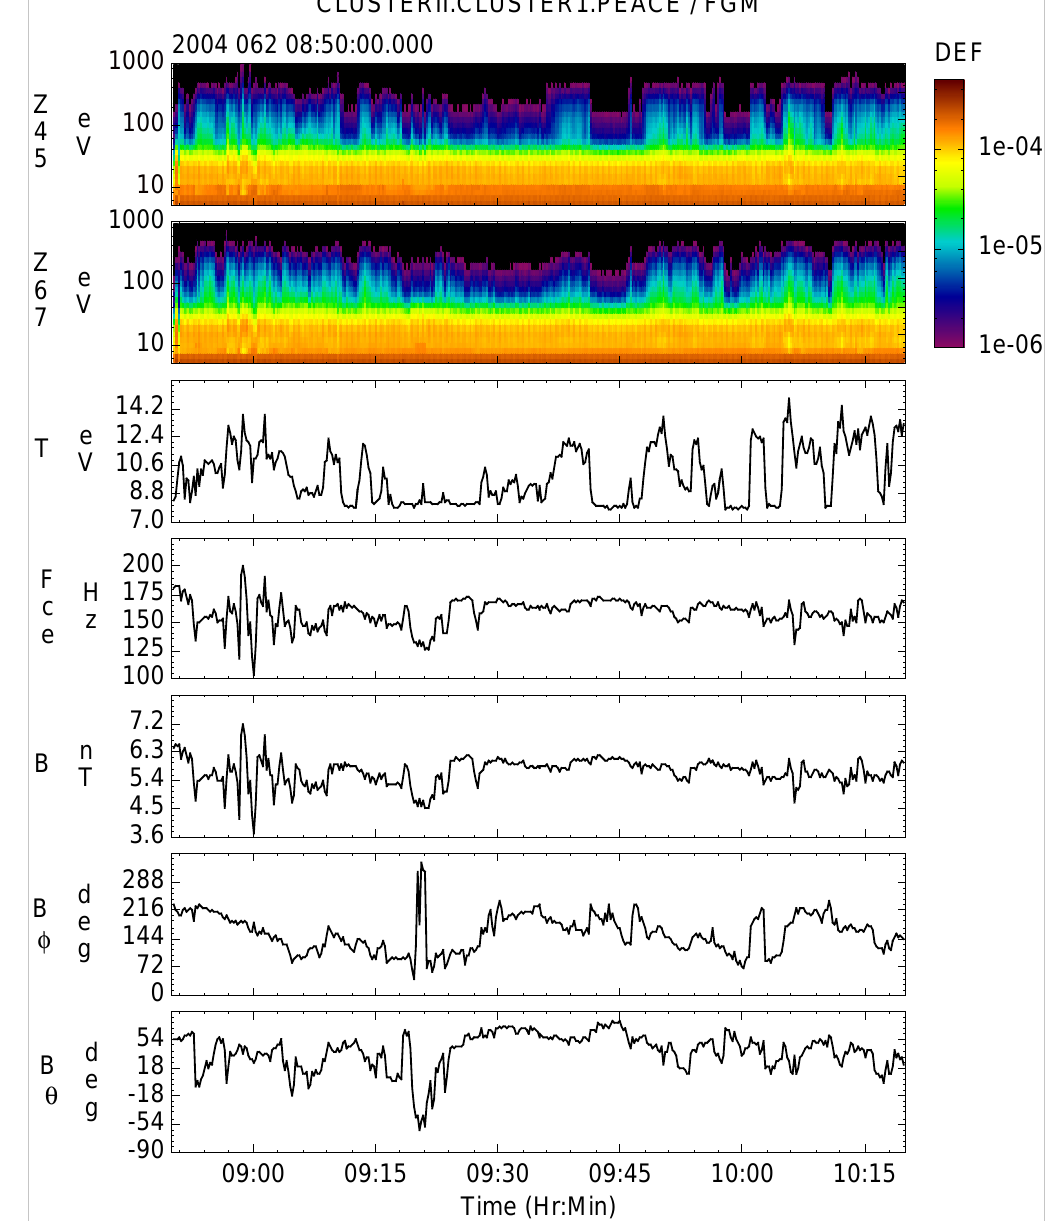
Fig. 2. Spectrograms of the differential energy flux (ergcm − 2 − sr − s ) . The data in the top-most plot are from the summed 4–5 polar zones and that in the lower plot are from the summed 6–7 polar zones. Together they cover an elevation from − 30 ◦ to 30 ◦ in the instrument frame of reference. From top to bottom, the other panels show the electron temperature, the electron cyclotron frequency and the spherical components of the magnetic field covering the time frame during which intervals of scattering of the strahl are observed. All data are from